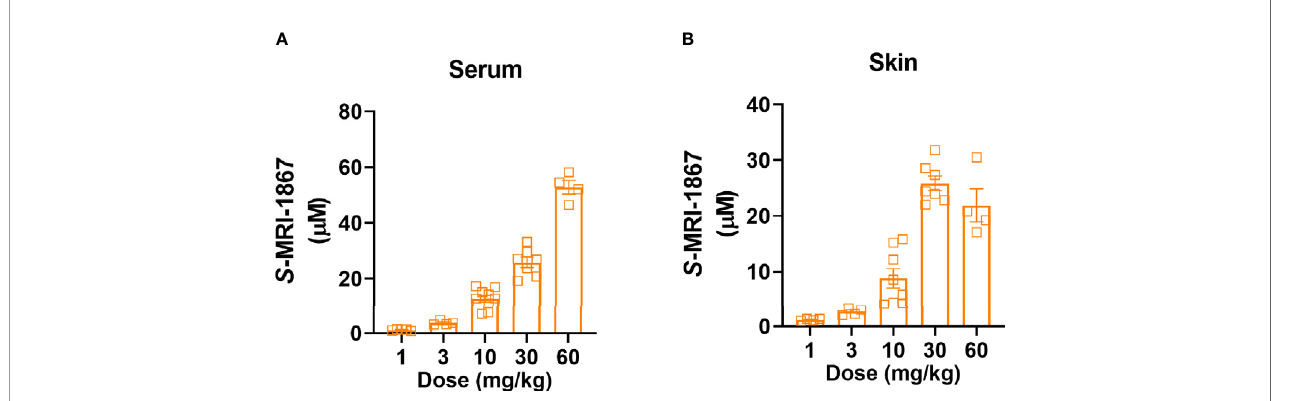
FIGURE 3 | Dose-dependent systemic and skin exposure of MRI-1867 in Mdr1 ( − = − ) dose of 14 days oral administration at 1, 3, 10, 30, and 60 mg/kg doses in bleomycin-treated Mdr1 ( − = − ) per